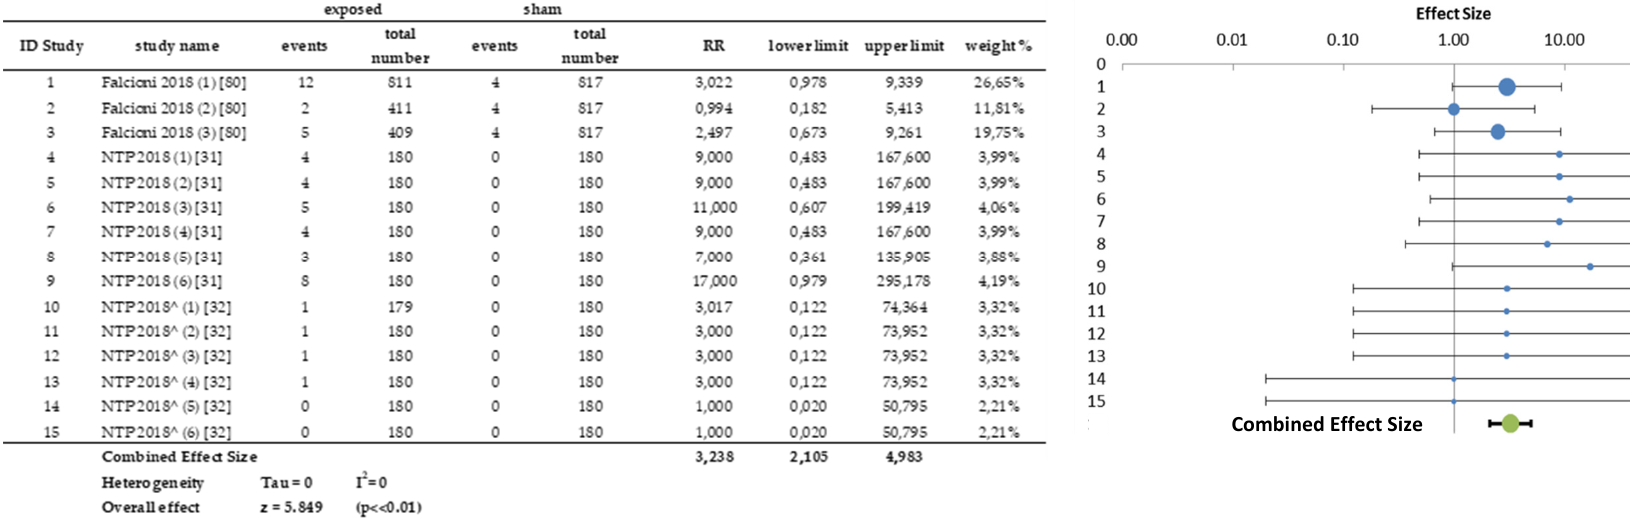
Combined Effect Size